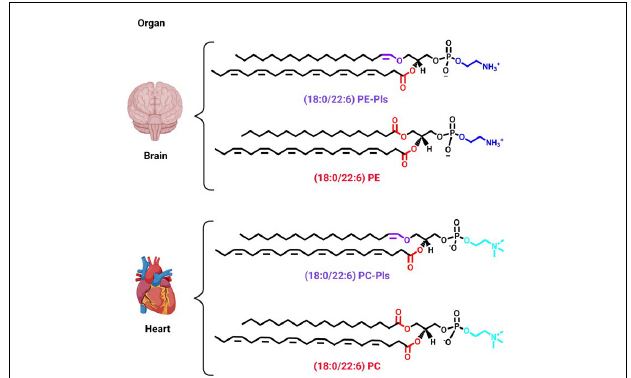
FIGURE 1 | Predominant plasmalogen species in different organs. A cartoon showing two organs, i.e. , brain and heart, to exemplify the chemical structure of the predominant plasmalogen species in those organs. Plasmenylethanolamine [18:0/22:6